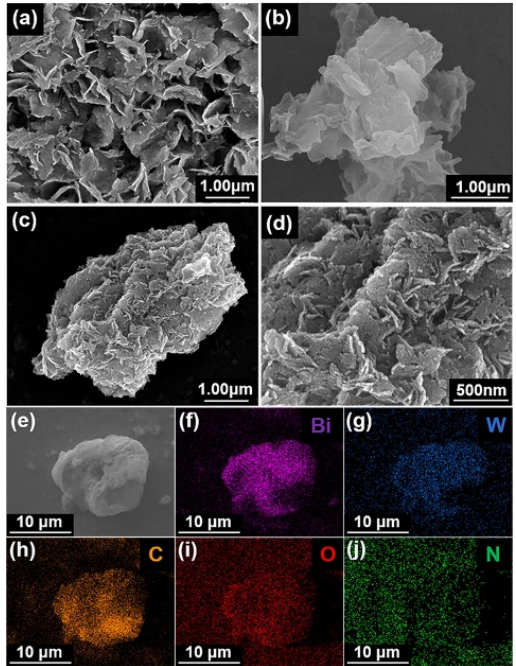
Figure 11. SEM images of ( a ) BWO nanosheets, ( b ) PI, ( c , d ) 30% PI@BWO and magnification, ( e ) FE-SEM images of 30% PI@BWO and ( f − j ) EDX element mapping images of Bi, W, C, O, and N.